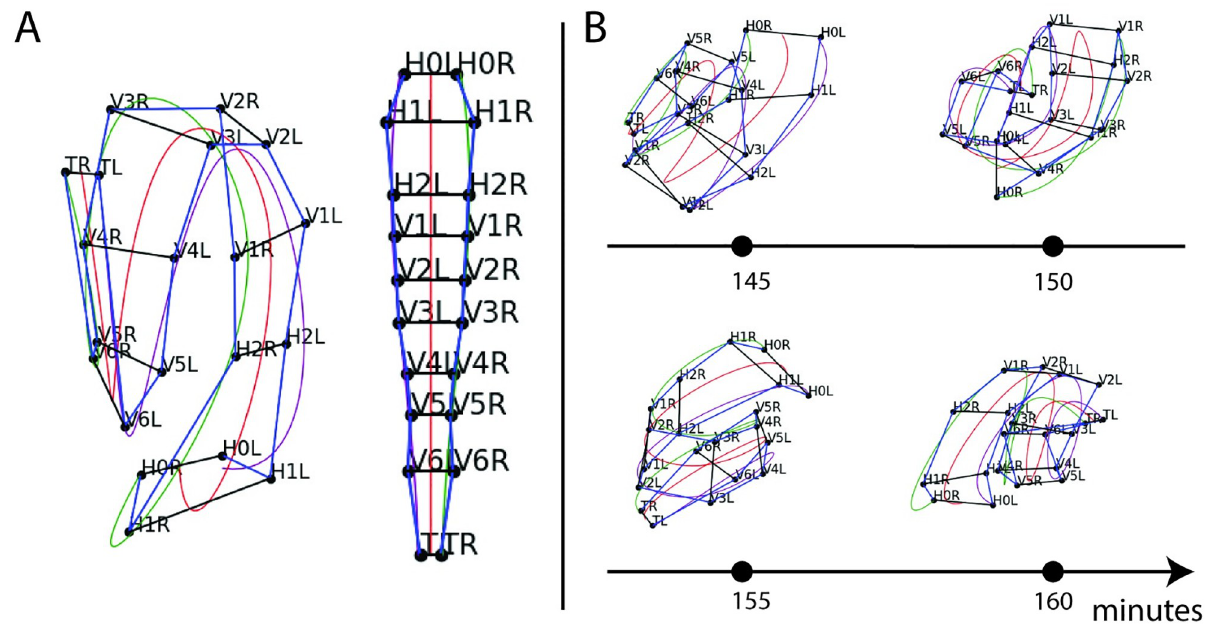
Fig 1. Seam cells are used to recover C. elegans posture in high spatial resolution, low temporal resolution imaging. A: Manually identified seam cell nuclei from an imaged C. elegans embryo. The cells form in pairs; they are labelled anterior to posterior: H0 , H1 , ... , V6 , T . The identification of all seam cells reveals the embryo’s posture. Natural cubic splines through the left and right-side seam cells estimate the coiled embryo’s body. The left image depicts identified nuclei connected to outline the embryo; splines are used to untwist the embryo, generating the remapped straightened points in the diagram on the right. B: Labelled nuclear coordinates from a sequence of four images. The embryo repositions in the five minute intervals between images, causing failure of traditional point-set matching approaches.